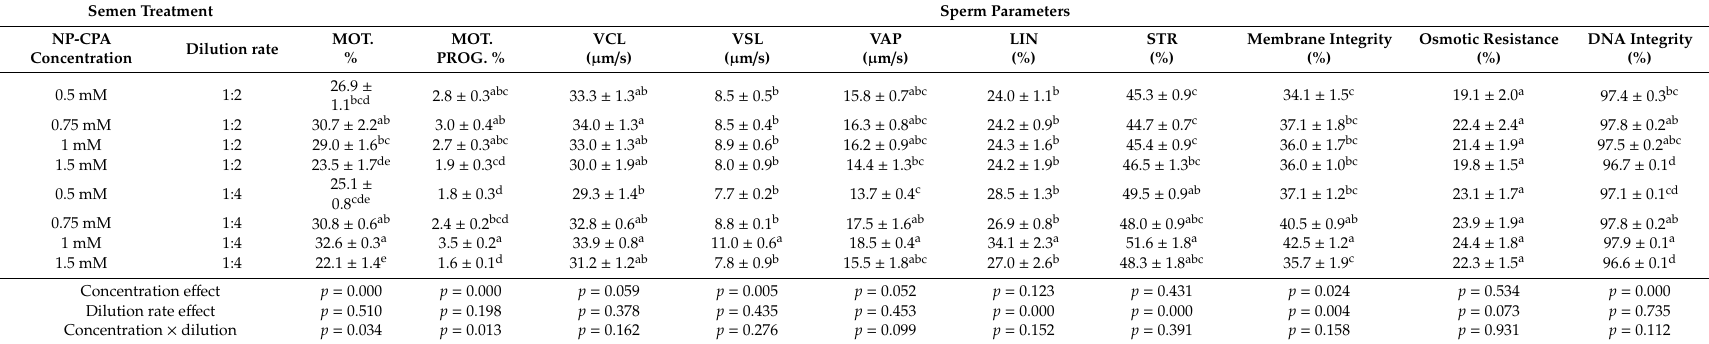
Table 6. Sperm quality variables (mean ± S.E.M.) obtained in turkey semen frozen in the presence of Ficoll considering di ff erent concentrations and two dilution rates (N = 8). Semen